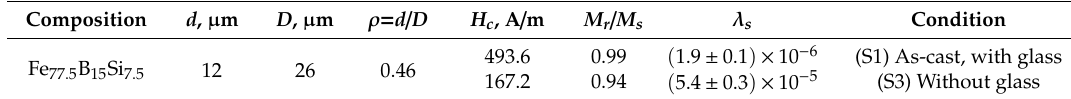
Table 1. Geometrical and magnetic parameters of glass-covered (S1) and glass removed